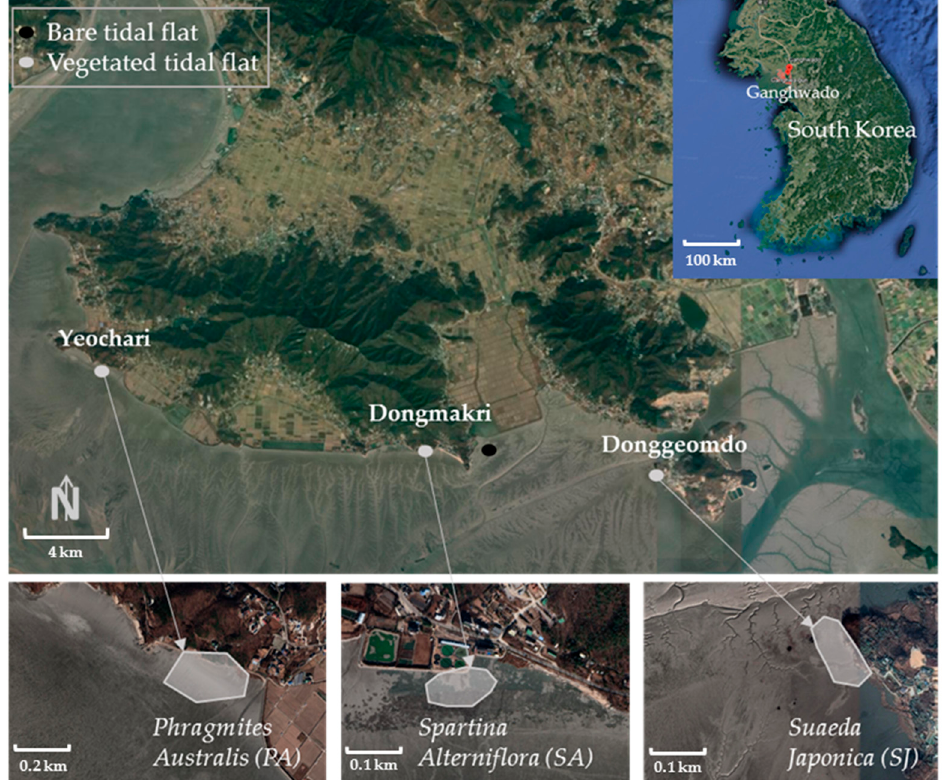
Figure 2. Study areas, Ganghwa-do tidal flat (image source: https://earth.google.com, accessed on 14 July 2021).